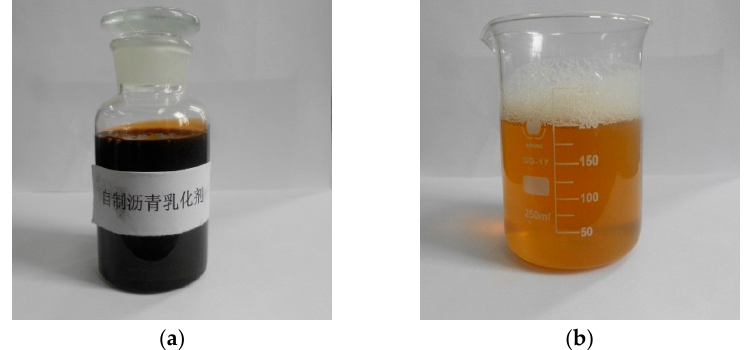
Figure 2. BE-4 emulsifier and aqueous solution: ( a ) BE-4 emulsifier; ( b ) BE-4 emulsifier aqueous solution. Table 1. Technical properties of the components of the waterborne epoxy emulsified asphalt.